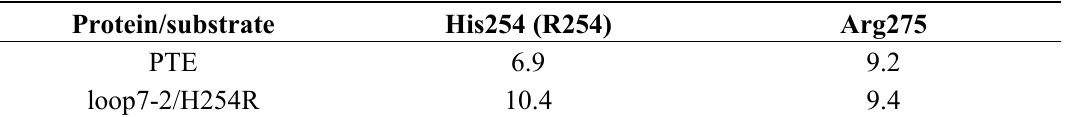
Table 4. Residues of the Active-Site Region with Large pKa